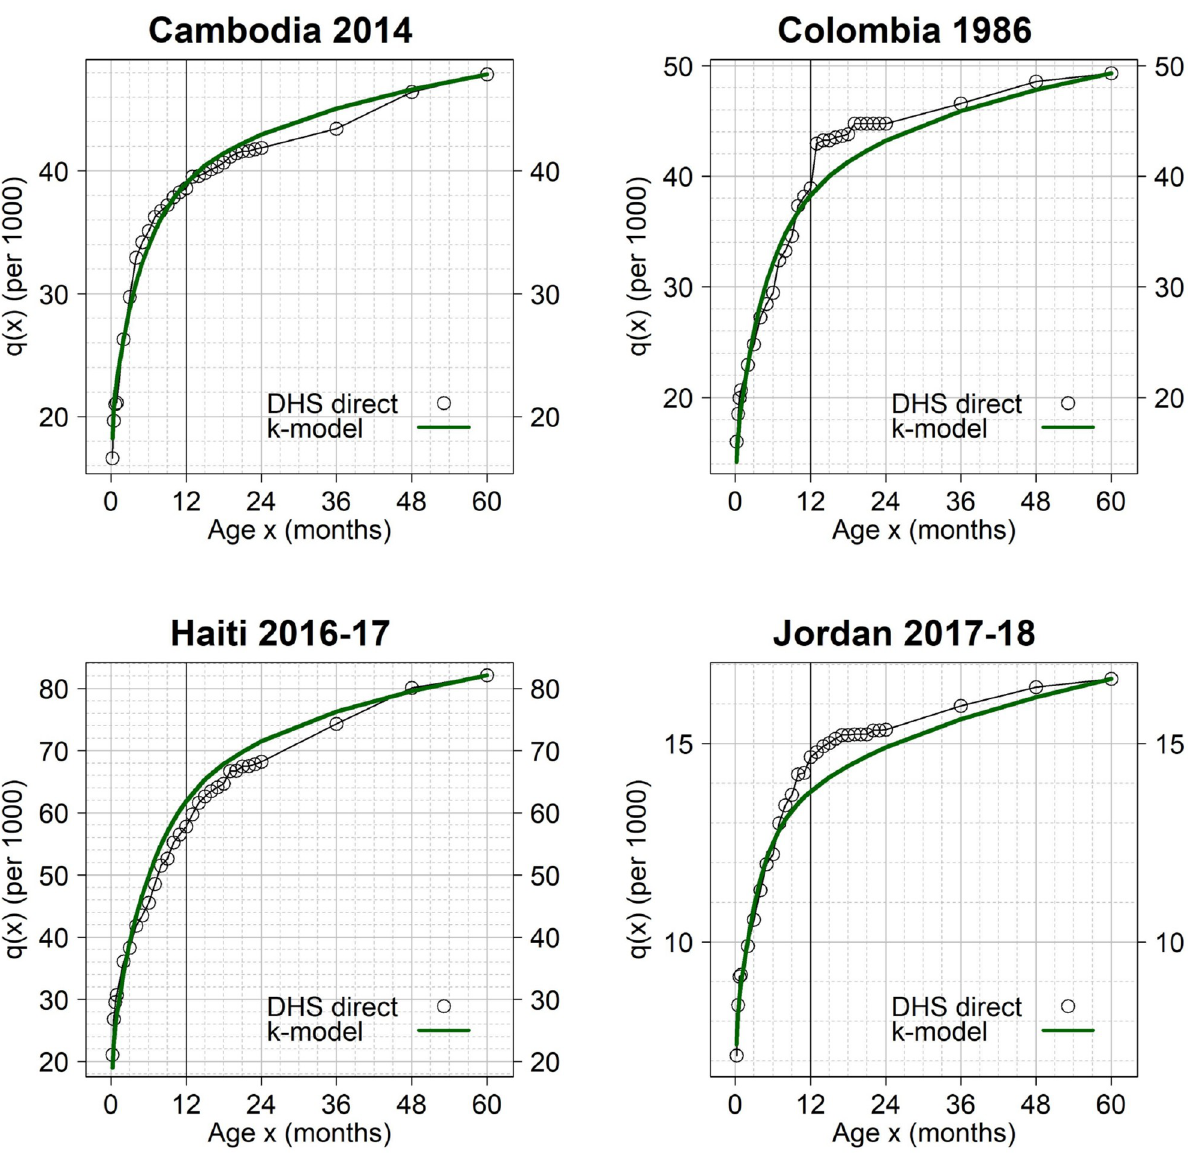
Fig 7. Examples of surveys with relatively good fit of the k-model. Prediction errors are between the 90% and 99% maximum values. The k-model was fitted to the observed q ( x ) values using ages 0–8 and 24–60 months only. The ticker vertical line indicates the comparison between the observed and predicted infant mortality rate